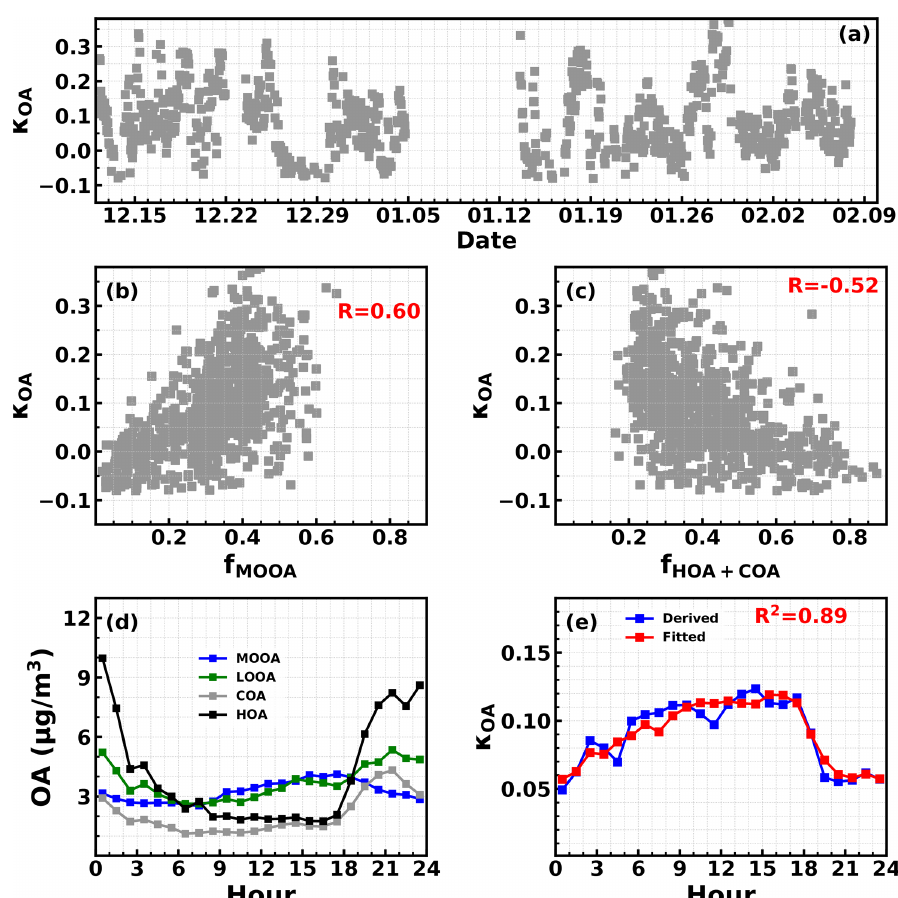
Figure 4. Time series of derived κ OA (a) . Correlations between derived κ OA and mass fractions of MOOA (b) and HOA + COA (c) in total organic aerosols. (d) Average diurnal variations of derived κ OA (blue) and corresponding fitted ones. (e) Average diurnal variations of resolved mass concentrations of organic aerosol